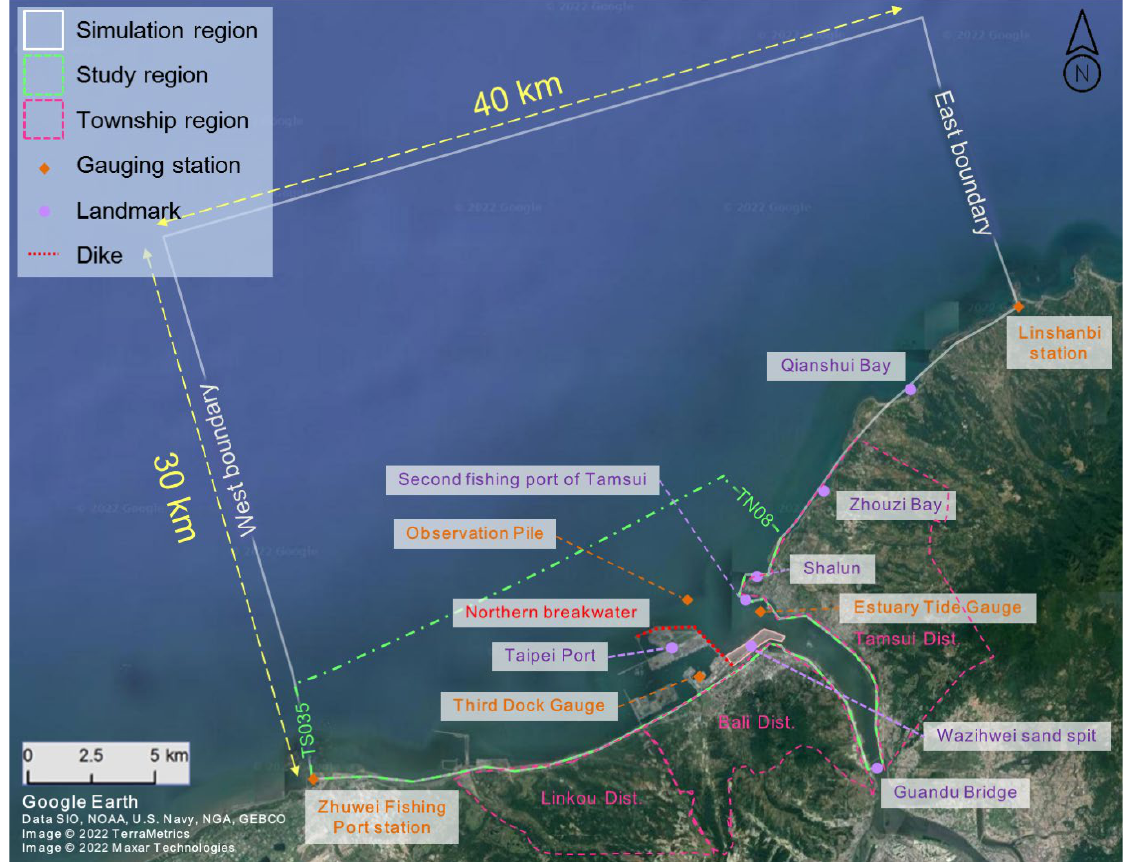
Figure 3. Relative position diagram of the study area and related monitoring stations.